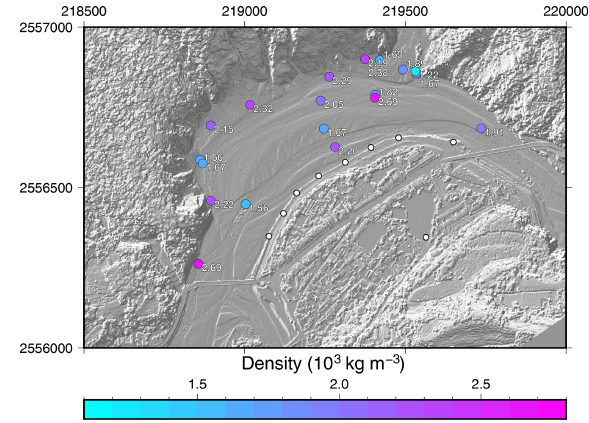
Figure 8. In situ density measured during the 2017 survey (colored dots; the value is also reported in white). Gravity sites are shown with white dots. Axes are in meters. The background is the shaded topography measured during the 2017